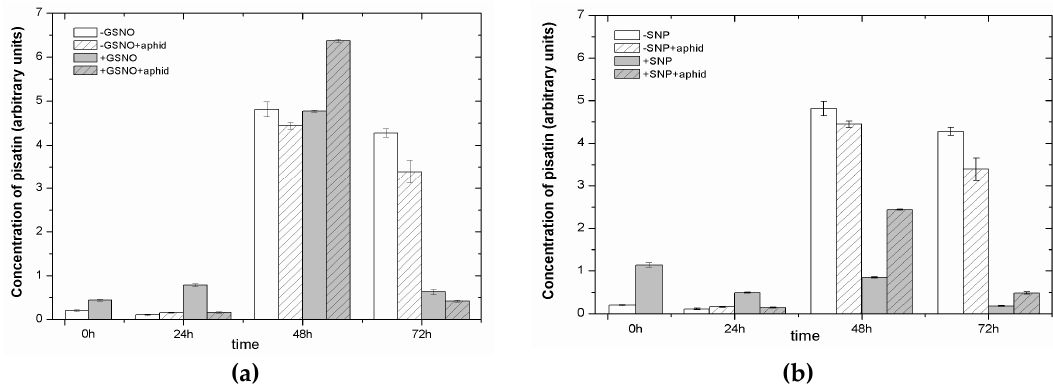
Figure 5. The effect of nitric oxide donors and A. pisum on pterocarpan pisatin levels in seedling leaves of Pisum sativum L. cv. Cysterski. The data were obtained in three independent experiments and statistically analysed using ANOVA ( p -values at α = 0.05). Hypotheses on the equality of means were verified by the two-sample t -test (Table S2). To account for multiple testing, we used the Bonferroni correction.